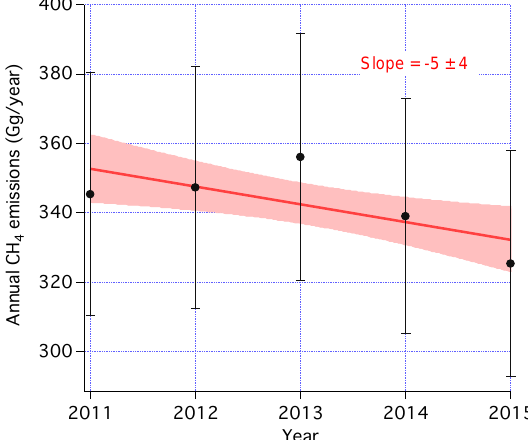
Figure 8. CLARS-FTS inferred annual CH 4 emission estimates (in unit of Gg per month), based on Hestia CO 2 emissions. The red line indicates the regression slope and the shaded area is the 25% confidence interval.